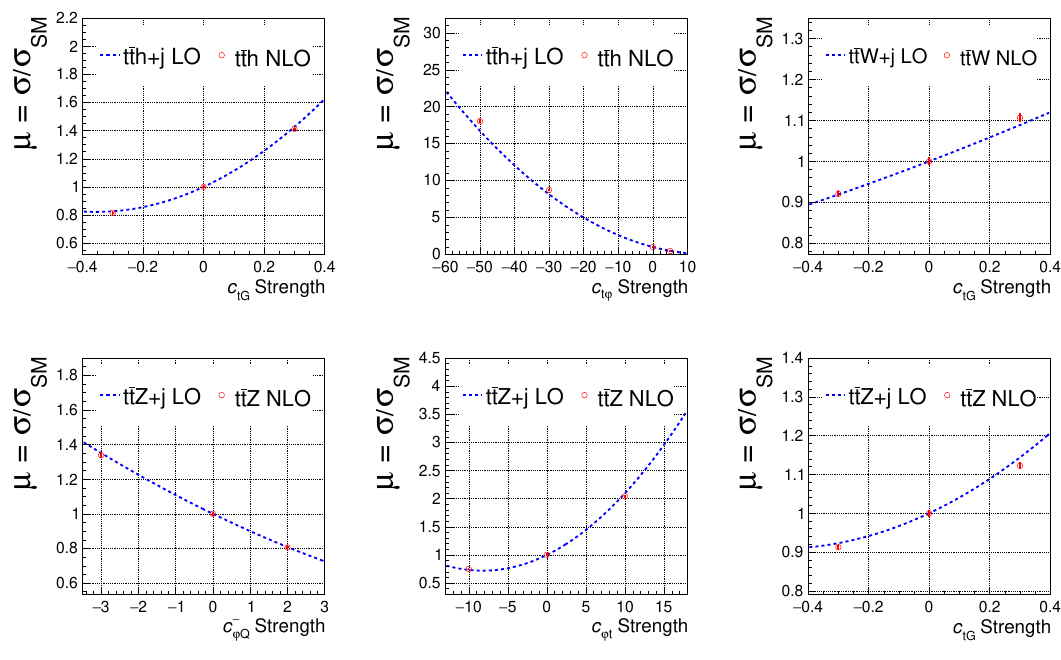
Figure 9 . Example quadratic cross section plots showing the LO samples (produced with an additional parton) compared with the NLO samples. The y axis shows the ratio of the cross section to the SM cross section; the LO fit is scaled by the LO SM prediction, and the NLO points are scaled by the value of the SM NLO point. As described in the text, the range for each Wilson coefficient is taken from the marginalized limits presented in ref.